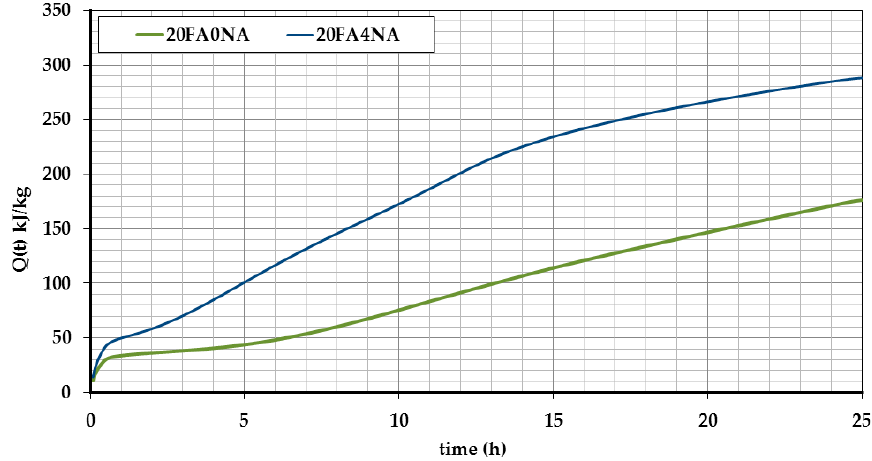
Figure 1. The accumulated amount of heat released over time.